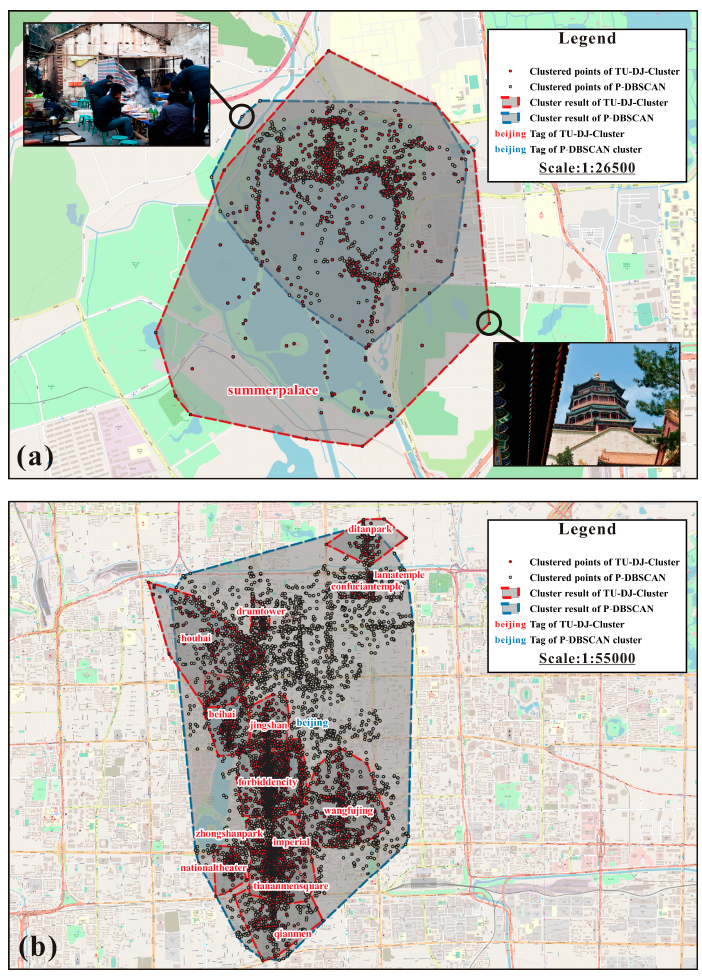
Figure 9. The comparison of results of TU-DJ-Cluster and P-DBSCAN: ( a ) Summer Palace; ( b ) area around the Forbidden City (The photos in Figure 9a are licensed under the Creative Commons Attribution License).